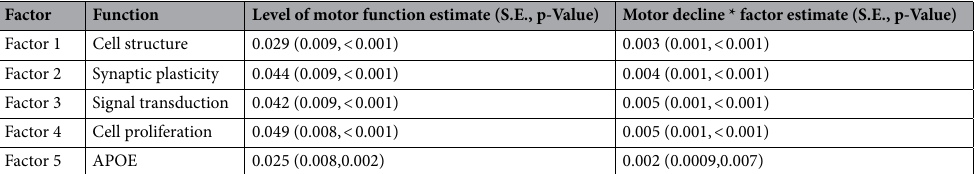
Table 2. Motor resilience factors and motor decline. The exploratory factor analysis applied to the proteotypic peptides identified in the current study (Fig. 4) identified five different factors. Inspection of the peptides clustering within each factor suggests that each factor may represent a distinct biological function. We constructed an average score for each of the 4 factors based on the constituent peptides obtained for each factor. There was only one protein in Factor 5. Each row shows the results for a single linear mixed-effect model which examines the association of the level of each of the 5 factors with the level of global motor score proximate to death and the interaction of each factor with the annual rate of change in global motor score prior to death (Motor Decline * Factor). Each cell shows the estimate (standard error and p-value) for the term shown in the left-hand column. Each model also included an additional 5 terms including Time (annual rate of motor decline), Age, Sex and their interaction with the annual rate of motor decline which are not